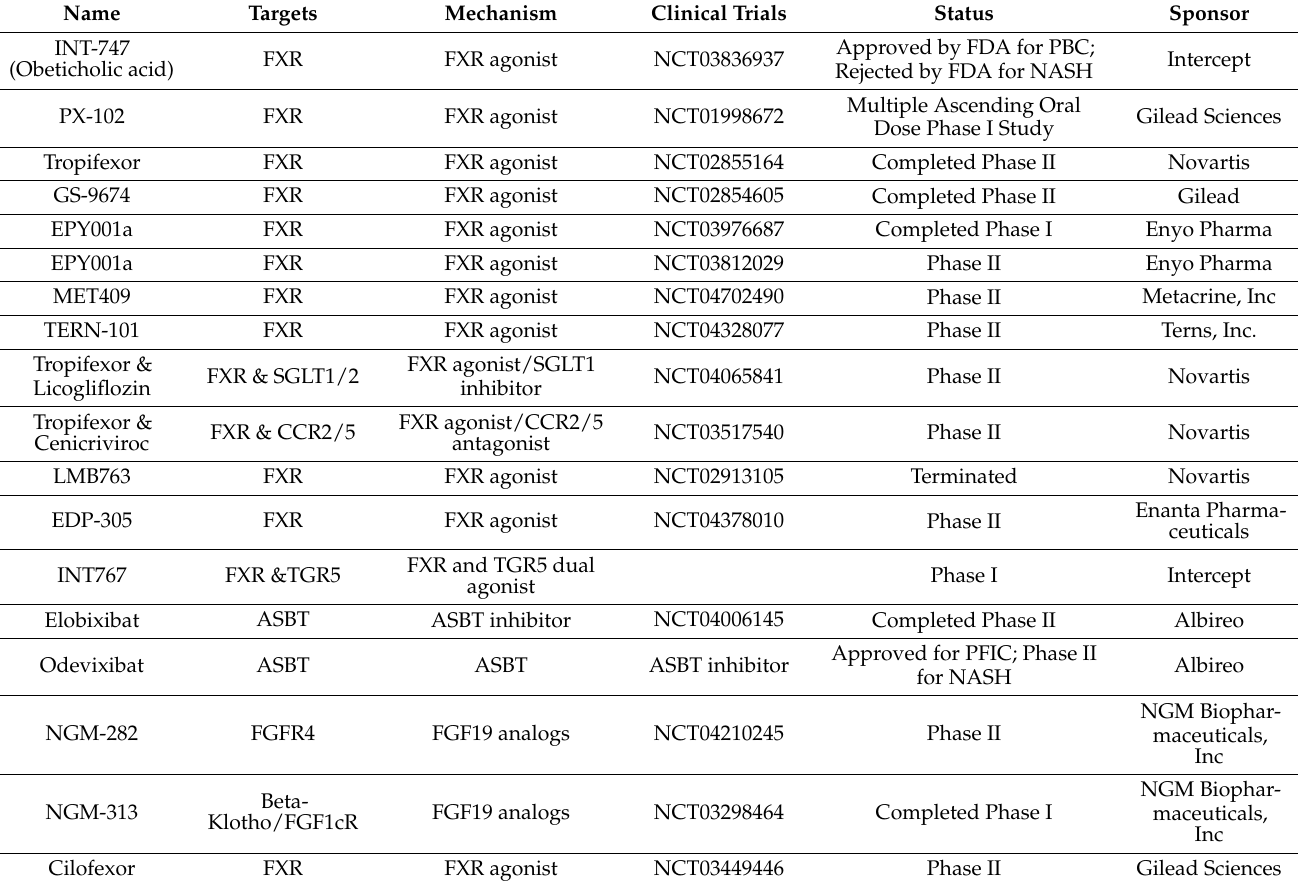
Table 1. List of the major clinical trials targeting enterohepatic BA circulation for the treatment of NASH.